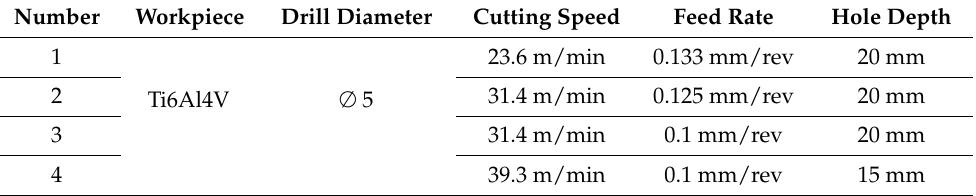
Table 4. Experimental conditions.